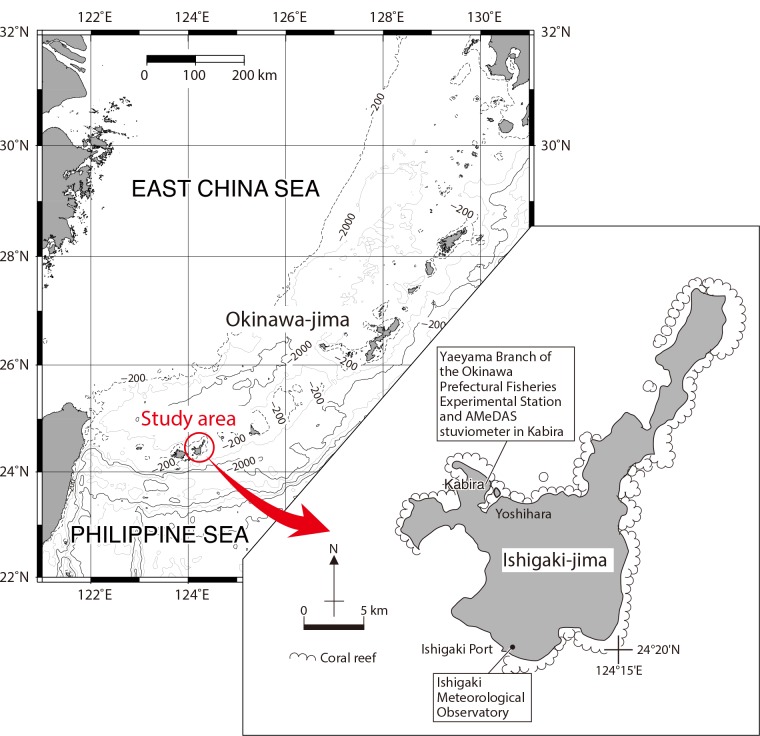
Location and map of the study site.(A) Study area in Ishigaki-jima (Ryukyu Islands). Bathymetric data are from ETOPO1 Global Model [40]. (B) Map of Ishigaki-jima.